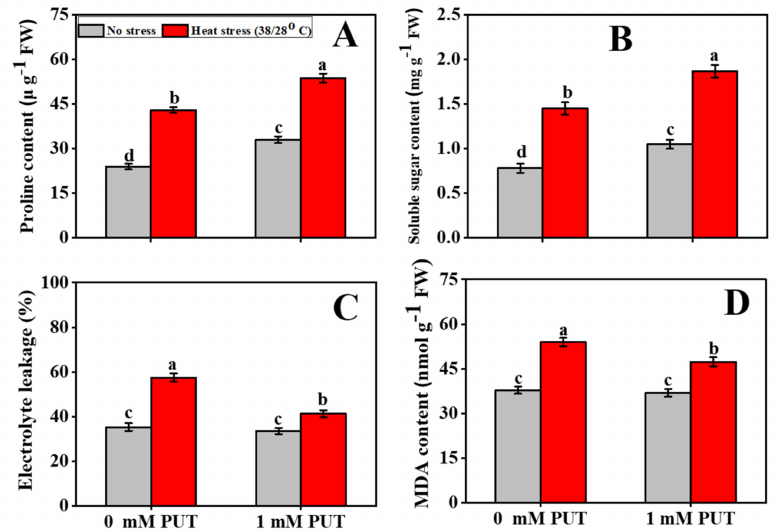
Figure 6. Interactive effects of Putrescine and high temperature on ( A ) Proline content, ( B ) Soluble sugar content, ( C ) Electrolyte leakage, and ( D ) MDA content in tomato seedlings. The data denote the mean value ± standard error (n = 3). Different alphabetic letters represent the significant differences among the treatments at p < 0.05, according to Tukey’s